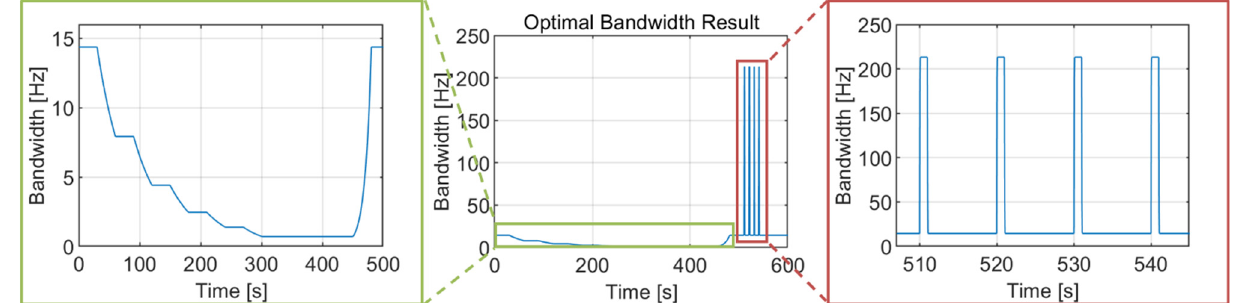
Figure 10. Optimal bandwidth variation during the simulation. The noise bandwidth is narrowed to 0.7 Hz as the C/N 0 is lowered to 5.4 dB-Hz and widened to 213.3 Hz as the jerk dynamic stress increases to 411 g/s.